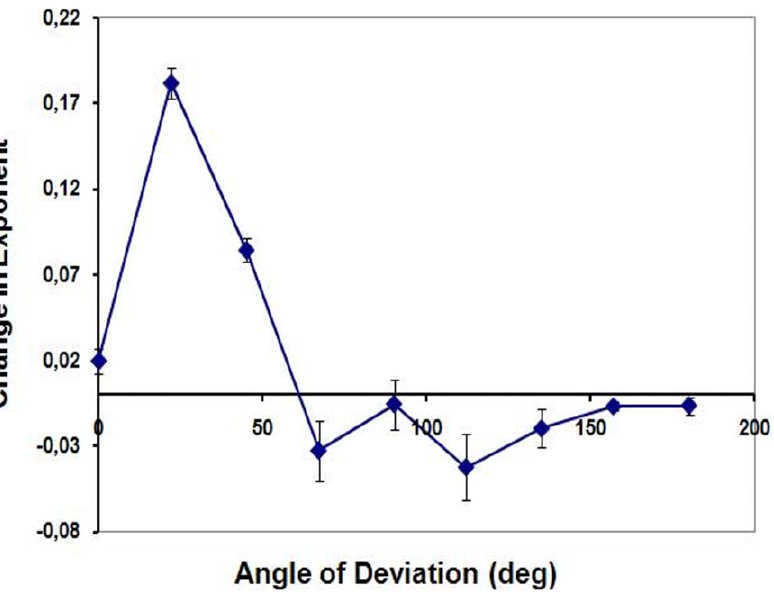
Figure 4. The results of Experiment 1. The average of the three observers for the change in perceived exponents (from actual value 1) of the second half of the trajectory are shown for the 9 deviation angles. Positive exponents indicate smoothing whereas negative exponents indicate sharpening. Error bars correspond to 6 1 SEM.